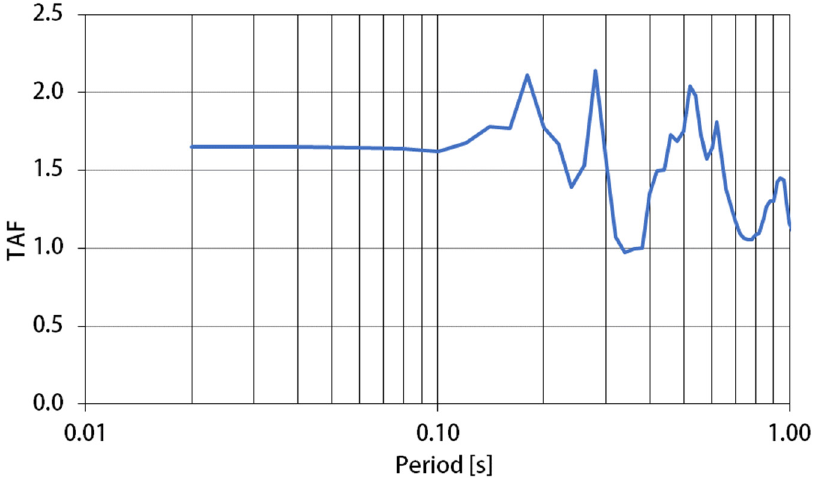
Figure 22. Topographic Aggravation Factor (TAF), after the Bouckovalas and Kouretzis [49] approach, in terms of (2-D)/(l-D) ratio of elastic response spectra obtained at the crest, for the Amoruso et al. [26] input. Figures 23 and 24 show, respectively, the comparison between Fourier amplitude spectra at the crest (1-D and 2-D) and behind the crest (2-D) and between elastic response spectra at the crest (1-D and 2-D) and behind the crest (2-D).